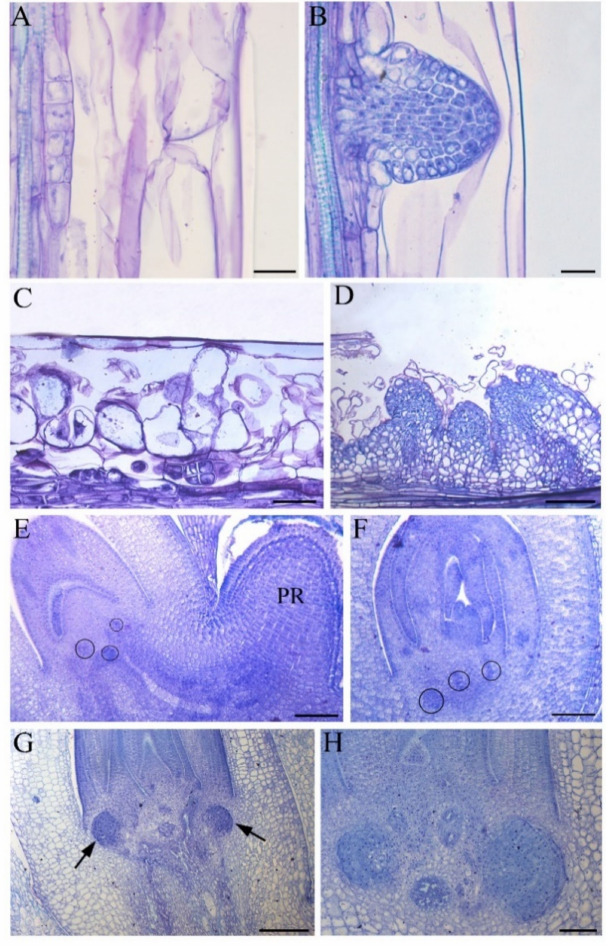
Figure 1. Adventitious root (AR) formation in hypocotyls ( A , B ) and thin cell layer explants ( C , D ) of Arabidopsis , and in the mature embryo of rice ( E – H ). First anticlinal cell divisions in the hypocotyl pericycle ( A ), and AR-primordium formation ( B ) in Arabidopsis seedlings. Radial longitudinal sections of Arabidopsis thin cell layers (TCLs) excised from the inflorescence stem and cultured under darkness in the presence of 10 µ M of indole-3-butyric acid (IBA). Periclinal cell divisions in the stem endodermis and meristemoid formation from the most superficial derivatives at day 5 ( C ), and further development of these meristemoids into AR primordia (( D ), day 10). Mature embryos of rice showing meristematic clumps (circles) initiating AR primordia at the scutellar node ( E , F ). Adventitious root primordia at the scutellar node at day 3 of germination (( G ), arrows). Dome-shaped adventitious root primordium with cap differentiation (( H ), day 4 of germination). PR, primary root. Longitudinal sections stained with toluidine blue. Bars = 20 µ m ( A , B ), 50 µ M ( C ), 100 µ M ( H ) and 200 µ m ( D – G